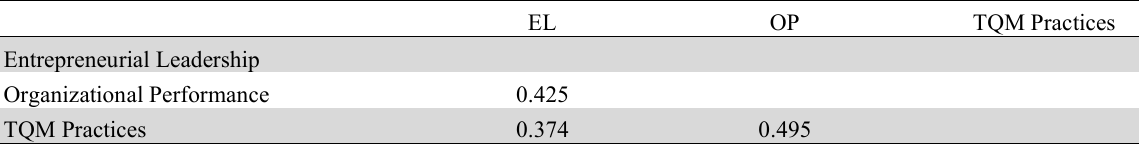
Heterotrait –Monotrait Ratio